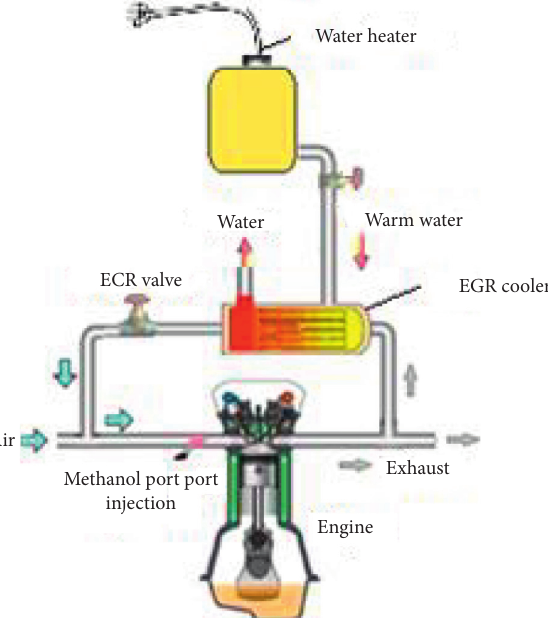
Figure 2: Layout of EGR system applied for the